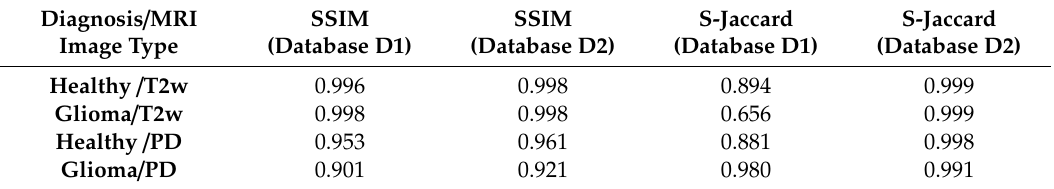
Table 1. The SC values for both pathologies and MRI image